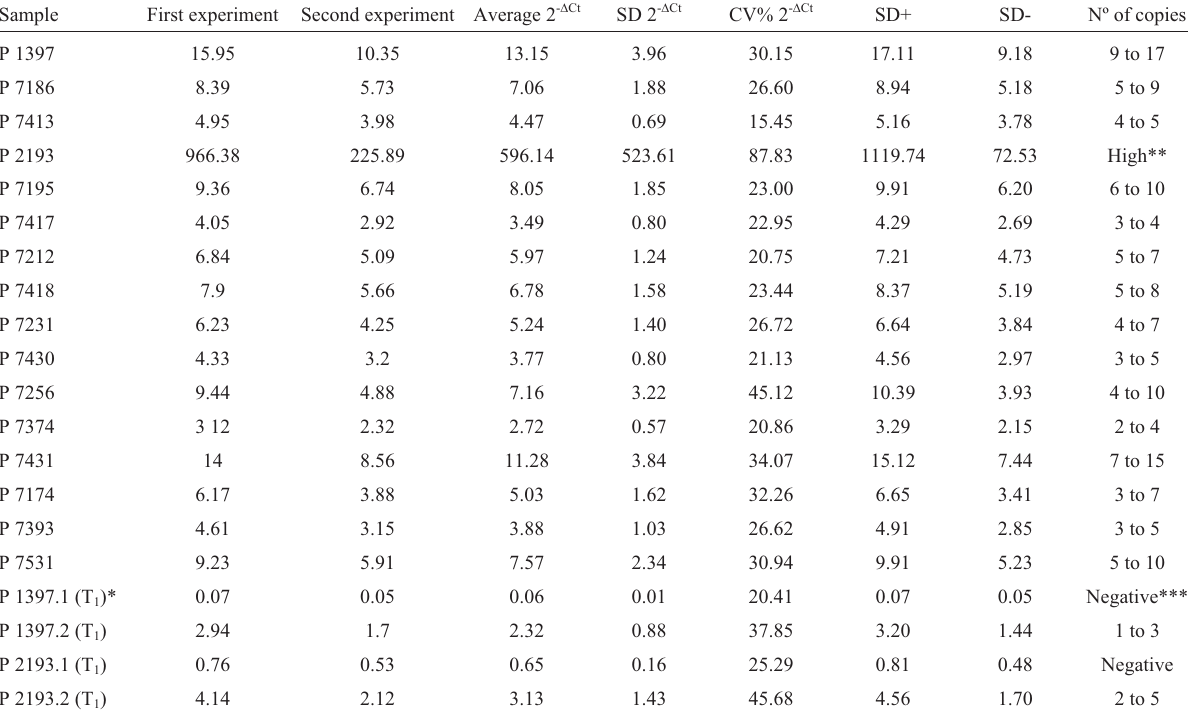
Table 1 - Estimation of AtDREB2A copy number in generations T 0 and T 1 using qPCR and the 2 - (cid:3) Ct/2 method. The first column displays the selected events,thesecondandthirdcolumnsdisplaytheresultsfromtheindependentexperiments,thefourthcolumnliststheaverageofthetwoexperiments,and the fifth, sixth and ninth columns show the standard deviation (SD), coefficient of variation (CV%) and estimated copy number, respectively. Sample First experiment Second experiment Average 2 - (cid:3)